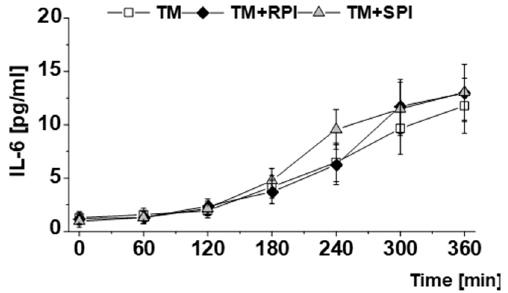
Figure 5. Postprandial response to the test meal (TM) with either no additional protein as reference ( □ ), 28 g rapeseed protein isolate (RPI) ( ♦ ), or 28 g soy protein isolate (SPI) ( ▲ ) with regard to plasma levels of interleukin-6 (IL-6). Differences in IL-6 concentrations after the ingestion of the three test meals over 6 h were evaluated with a mixed model to test the effects of treatment, time, and their interaction (treatment × time). The value at baseline (before treatment) was considered a covariate. All p values were adjusted according to the Tukey–Kramer multiple group comparison procedure. For time-point analysis, the paired t-test was applied. Significance was accepted as p < 0.05. Data are presented as LSMs ± SEs ( n = 19).